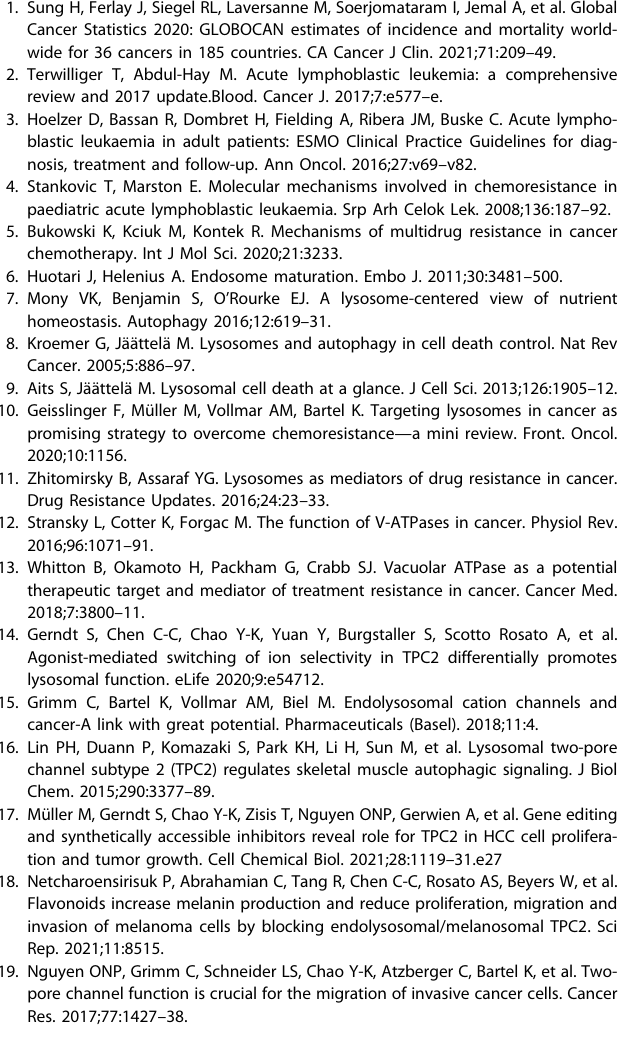
Fig. 7 Proposed mechanism of chemo sensitization by loss of TPC2 function. Loss of TPC2 function causes impairment of lysosomal functionality, including increased pH, increased lysosomal size, and increased susceptibility to lysosomal damage. Hence, TPC2 ko cells are not able to sequester weak base drugs within lysosomes, causing accumulation at their target sites and thus increased effectivity. Concurrently, lysosomal damage initiates lysosomal cell death mediated by cytosolic cathepsin B. These two pathways increase pro-apoptotic signaling, e.g. activating truncation of Bid, activation of the executioner caspase 3 and PARP cleavage, ultimately causing increased cell death in TPC2 ko